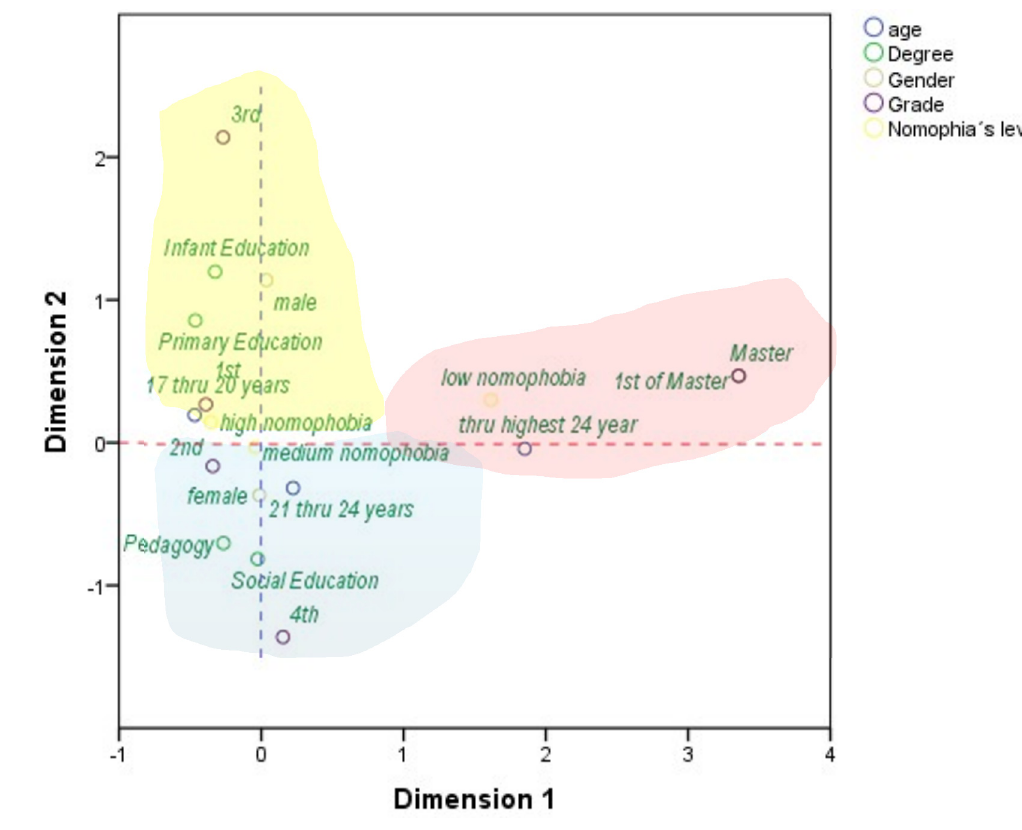
Figure 3. Joint plot of the category points.